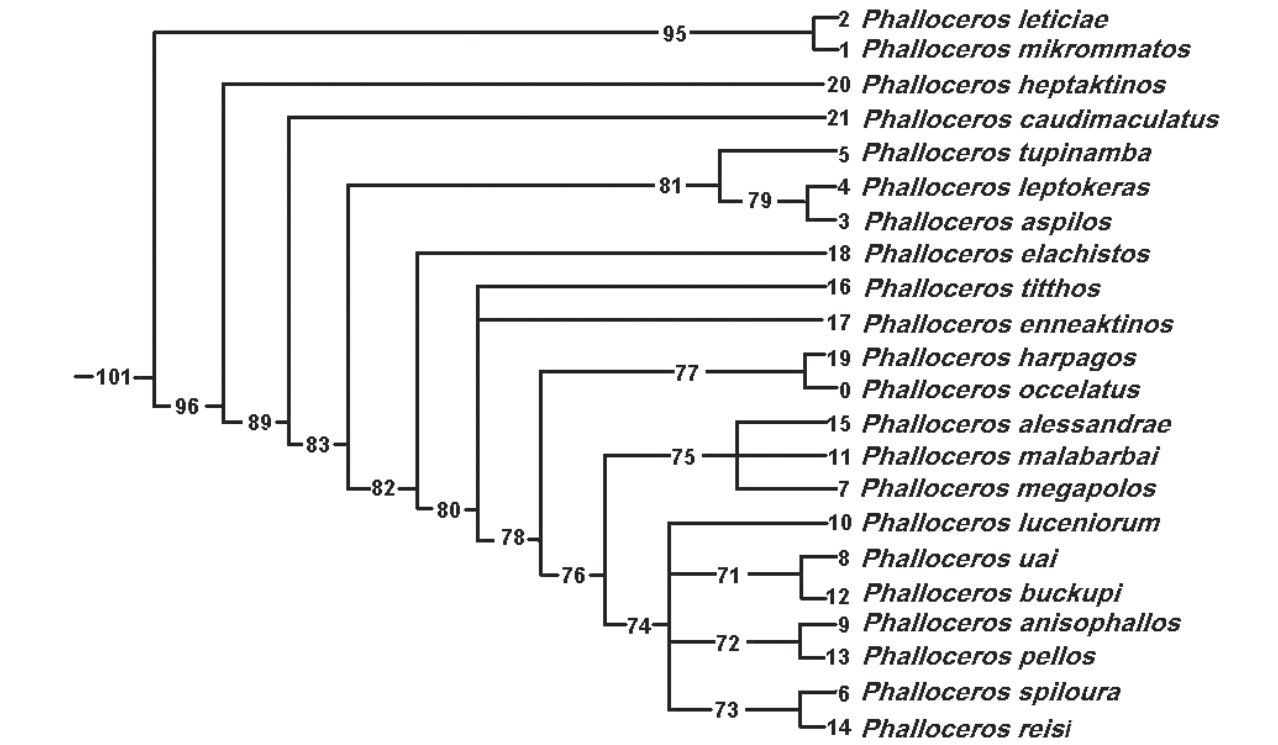
Fig. 1. Intrageneric relationships of Phalloceros species (Lucinda & Reis, 2005). The numbers on the branches refer to